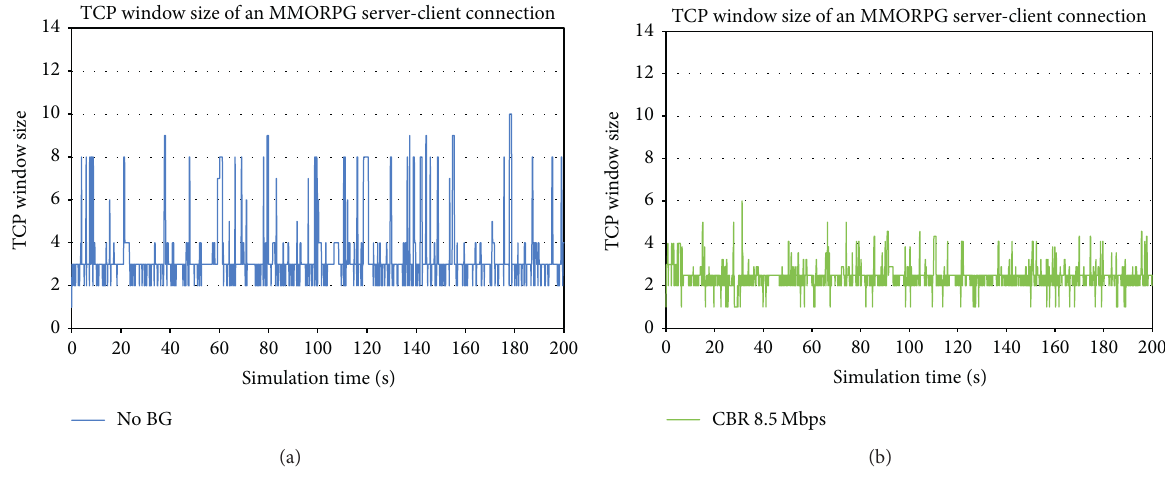
Figure 15: TCP window size, and server-client MMORPG traffic: (a) no background and (b) 8.5 Mbps background.